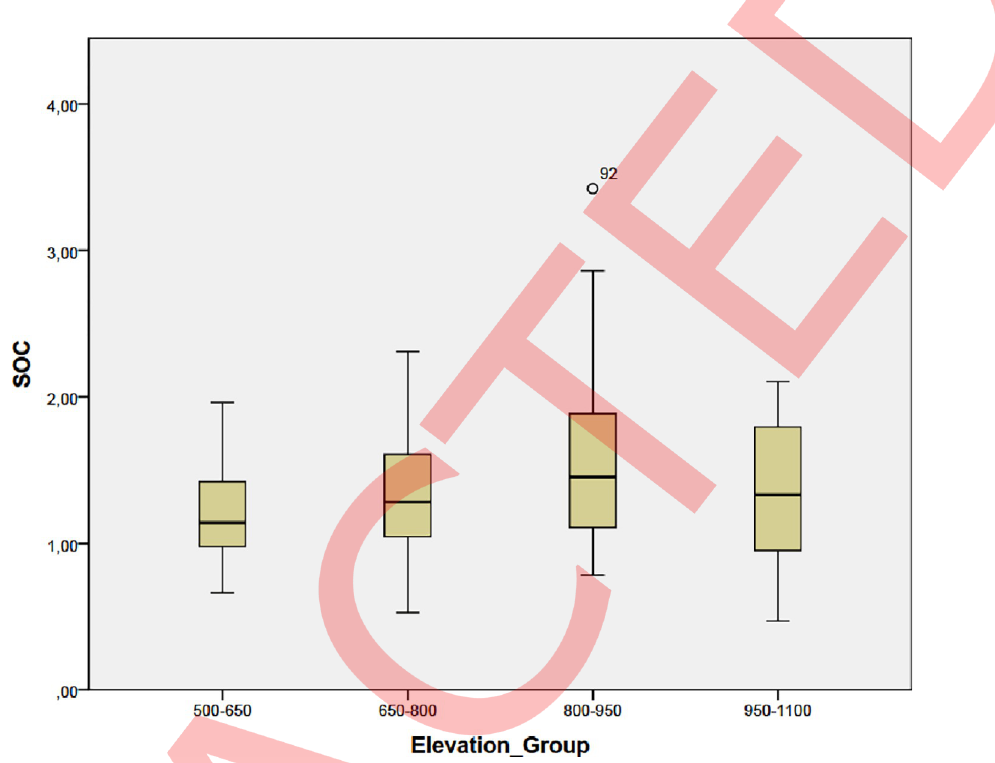
Fig 5. Soil organic carbon (SOC) content in different